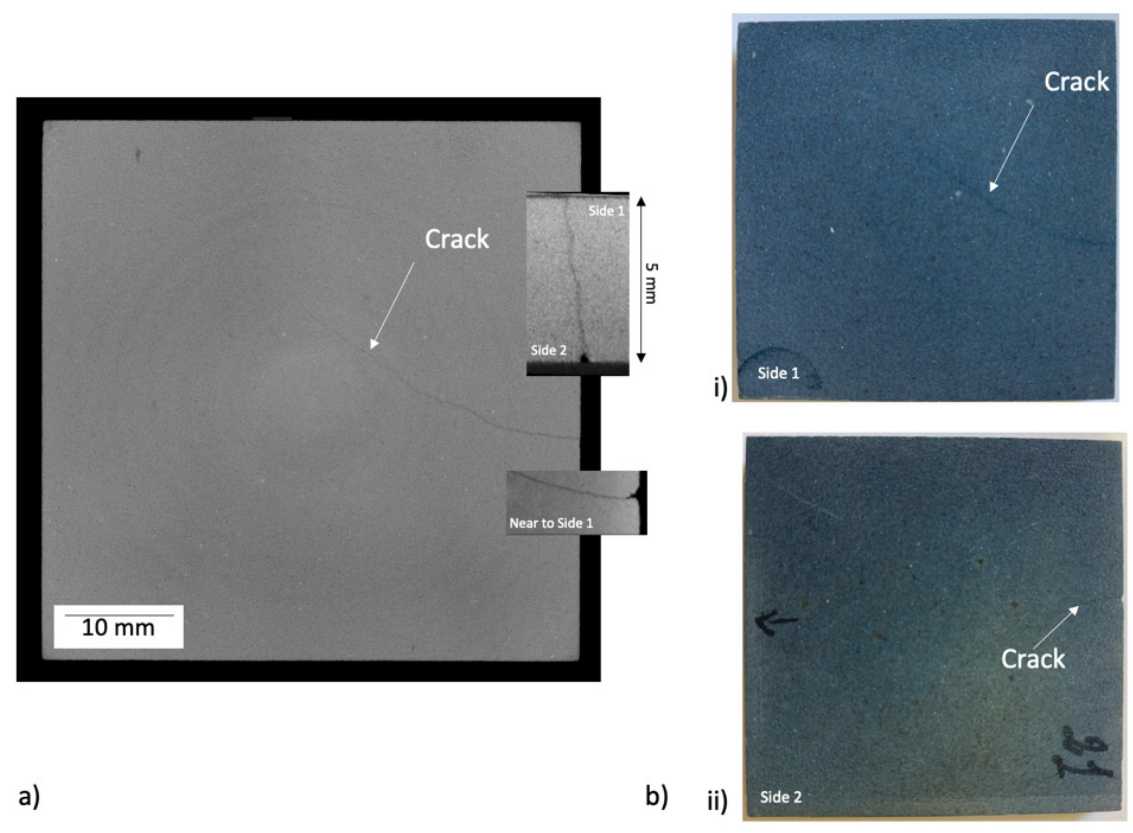
Figure 3. ( a ) µ XCT cross-section of a slab (slab 21—see Table 2). A through thickness crack propagates from near the center of one edge, reaching the center of the slab. The “ring” contrast is an image artefact. ( b ) Optical images of the two surfaces of the slab. The crack is slightly visible on side 1 (unirradiated) and barely visible on side 2 (solar irradiated). All images show the full 50 mm × 50 mm slab.